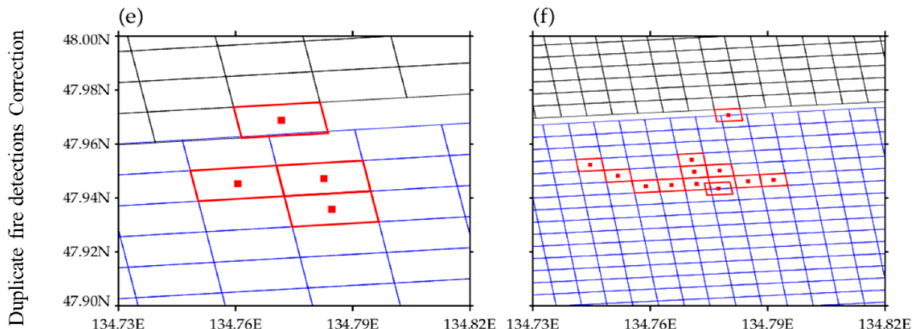
Figure 1. Example of duplicate fire detection correction of the Moderate Resolution Imaging Spectroradiometer (MODIS) 1-km fire product (left panel) and Visible Infrared Imaging Radiometer Suite (VIIRS) 375-m fire product (right panel). The example was detected by MODIS at 04:25 (UTC) and VIIRS at 04:24 (UTC) on 6 November 2015 in the study region. ( a , b ) False-color images overlaid with original detected fire pixels (footprints shown in red quadrangles) in the MODIS and VIIRS fire products, respectively. The background false-color images in ( a , b ) were composited using the MODIS 500-m reflectance at bands 7, 2, and 4 observed at 04:25 UTC, with mosaics in orange and red showing active surface fires; the white rectangles in the false-color images delineate regions shown in the panels below; ( c , e ) are the MODIS 1-km fire detections and the correction after removing the duplicate fire detections, respectively; the red quadrangles and dots inside are the boundary and center of the MODIS 1-km fire pixels; the blue and black quadrangles present the MODIS 1-km non-fire pixel footprints from the prior and subsequent scans, respectively; ( d , f ) are similar to ( c , e ) but for the VIIRS 375-m fire product.